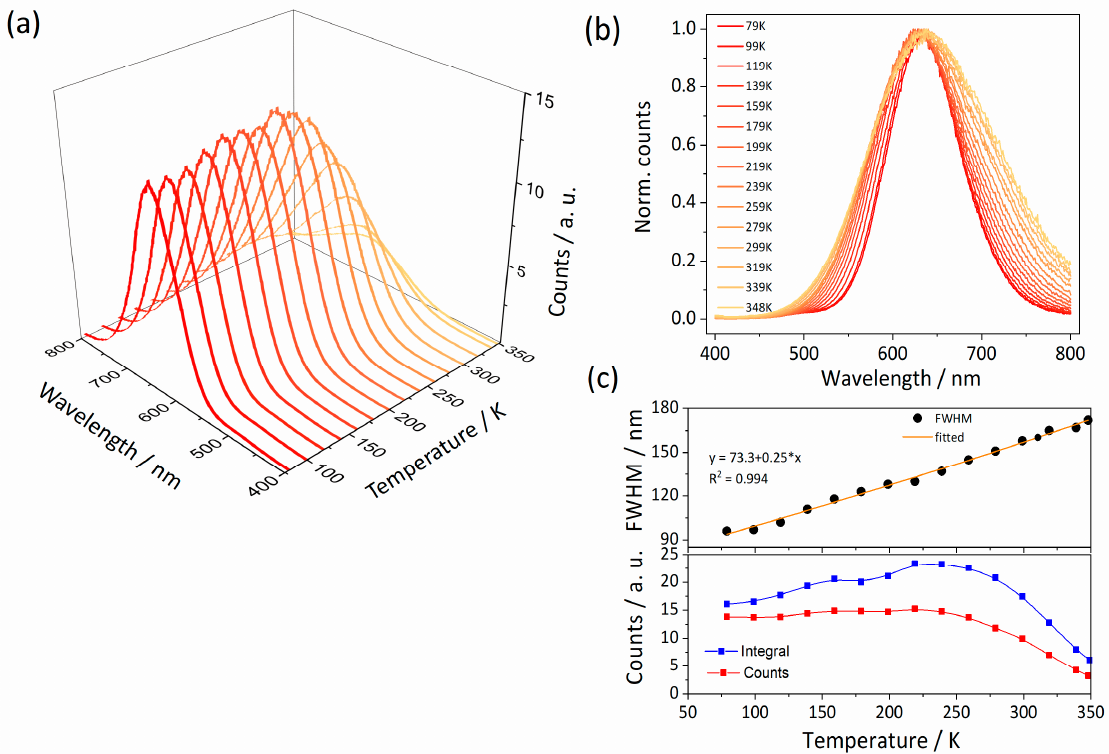
Figure 2. ( a ) PL emission spectra of [bppmCu 2 I 2 ] 2 sample at temperatures from 77 to 350 K with λ ex = 360 nm. ( b ) Normalized emission spectra of [bppmCu 2 I 2 ] 2 at different temperatures. ( c ) Temperature-dependent FWHM (top) and PL intensity (bottom).